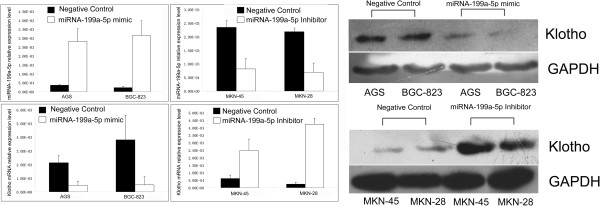
The transfection efficiency of miR-199a-5p and klotho target gene indentify in gastric cancer cells. (A, B) The transfection efficiency of miR-199a-5p inhibitor (MKN-45, MKN-28) and mimic (BGC-823, AGS) in gastric cancer cell. (C, D) The mRNA level changes of klotho after gastric cancer cell transfected with miR-199a-5p inhibitor (MKN-45, MKN-28) and mimic (BGC-823, AGS). (E, F) The protein expression changes of klotho in gastric cancer cells after transfected with miR-199a-5p inhibitor (MKN-45, MKN-28) and mimic (BGC-823, AGS).